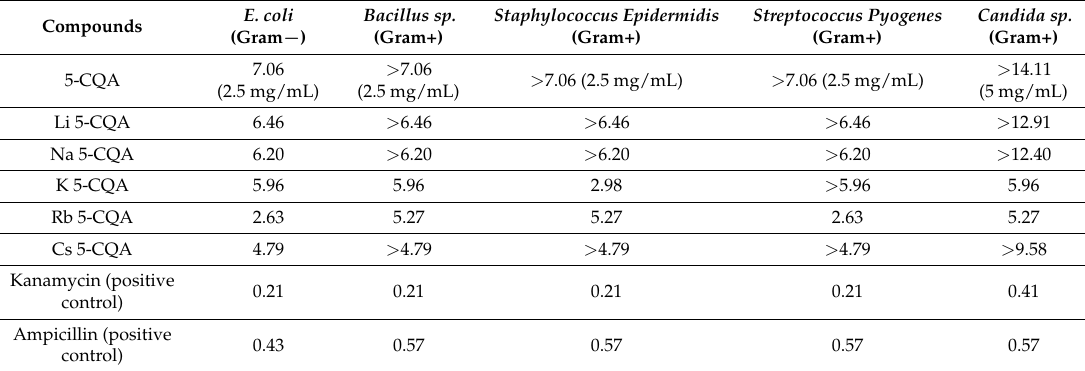
MIC (minimal inhibitory concentration) values (mM) of tested compounds against selected